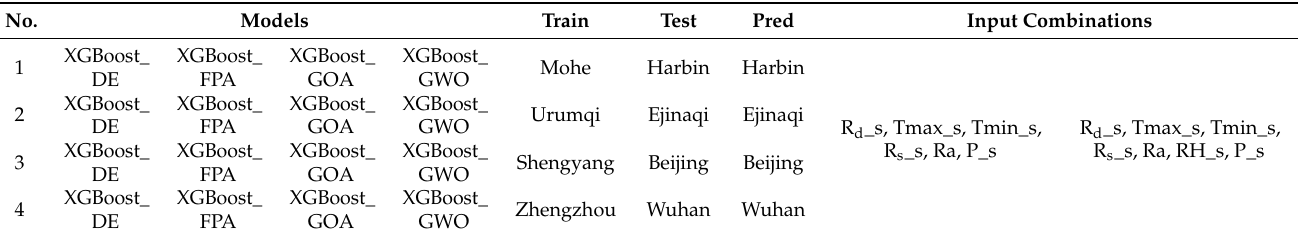
Table 4. The input combination of Himawari-7 satellite data based on four target stations and four neighboring stations in different